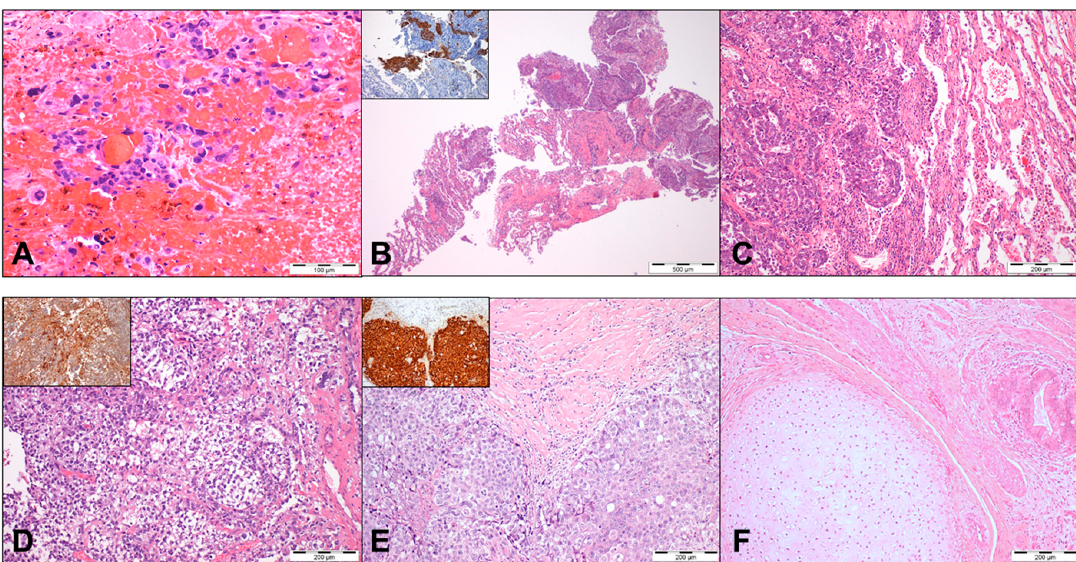
Figure 1. Illustrative histopathological examples of the infrequent tumor specimens from patients with the metastatic cisplatin-resistant disease. ( A ) A brain metastasis of a 35-year-old patient, presenting with stage III disease, undergoing multiple cisplatin-based courses of treatment, showing disease progression. The patient underwent excision of the brain metastasis, showing choriocarcinoma, in a bloody background. ( B ) A lung biopsy of a 21-year-old patient with a lung metastasis in the form of embryonal carcinoma, representing the disease progression after a first-line platinum treatment. Inset: tumor cells showed an immunoexpression of OCT3 / 4. ( C ) The previous patient was treated with multiple courses of cisplatin-based chemotherapy, but the disease progressed. He underwent salvage surgery, with a resection of lung metastases again showing a persistence of embryonal carcinoma, as illustrated in the figure, but ended up dying from disease. ( D ) A brain metastasis of a 25-year-old patient with stage III disease at presentation. He was treated with multiple courses of cisplatin-based chemotherapy, but the disease progressed under treatment with the emergence of a brain metastasis showing a yolk sac tumor histology. Inset: tumor cells showed a di ff use immunoexpression of alpha-fetoprotein. The patient underwent brain resection and radiotherapy to the brain but died from disease. ( E , F ) A post-chemotherapy retroperitoneal lymph-node dissection of a metastatic mass in a stage II patient. Dedicated sampling of the mass led to the finding of a small foci of a residual, viable nonteratoma disease, in the form of embryonal carcinoma, within a background of fibrosis and necrosis. ( E ) Inset: tumor cells showed an immunoexpression of OCT3 / 4. Within the specimen areas of the residual, mature teratoma were also present ( F ), with evidence of mature cartilage, smooth muscle, and intestinal epithelium. Cases were treated in our institute and retrieved from the pathology archive.